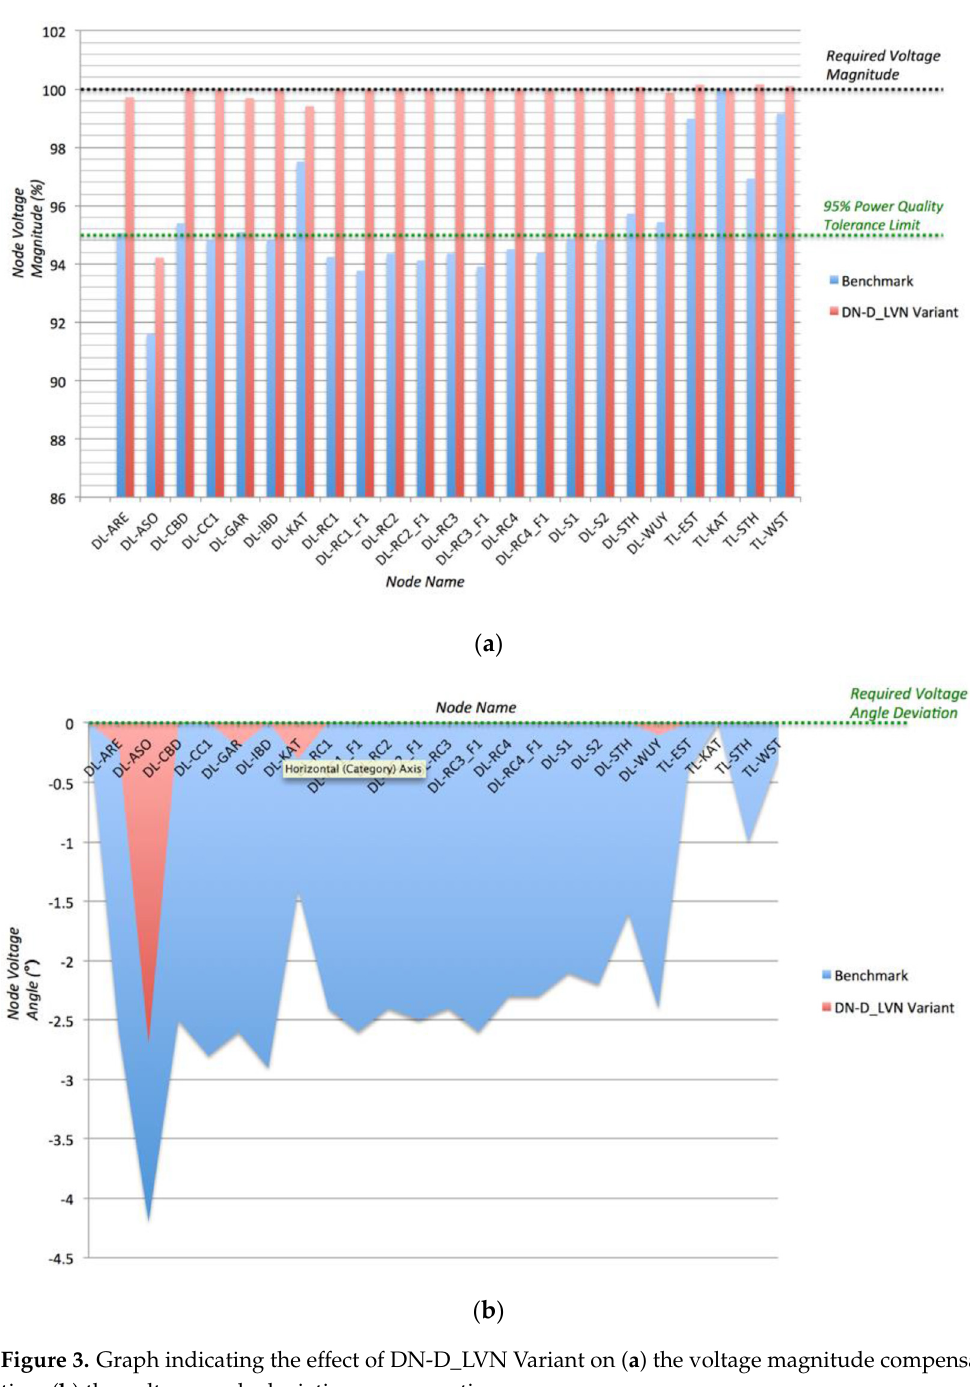
Figure 3. Graph indicating the effect of DN-D_LVN Variant on ( a ) the voltage magnitude compensation; ( b ) the voltage angle deviation compensation.